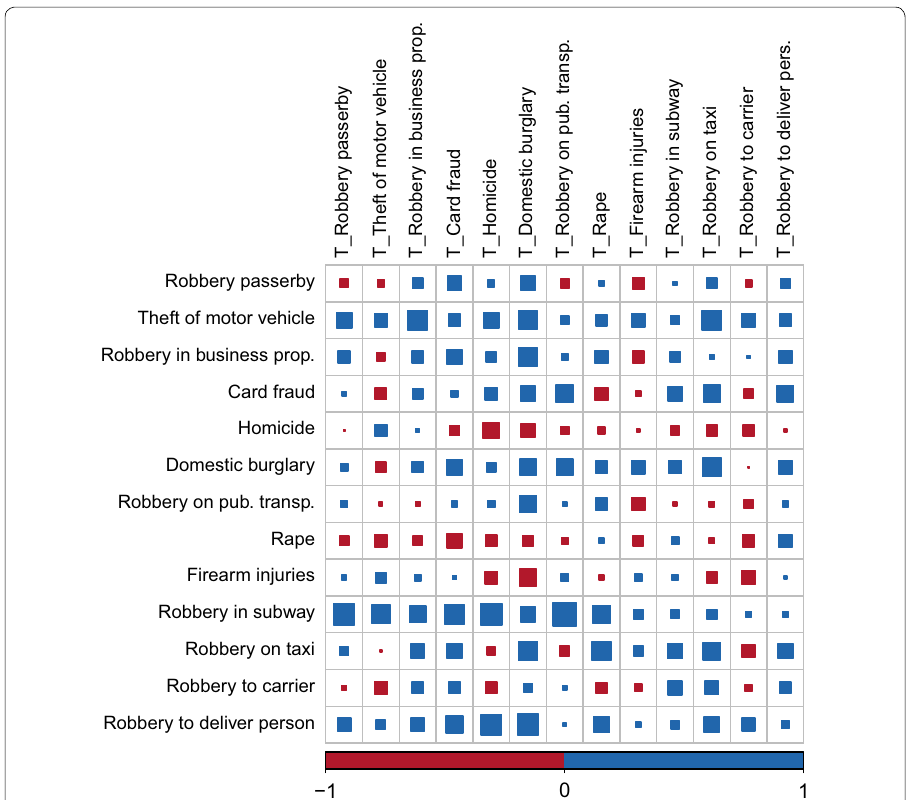
Fig. 13 Correlation between official crime data and